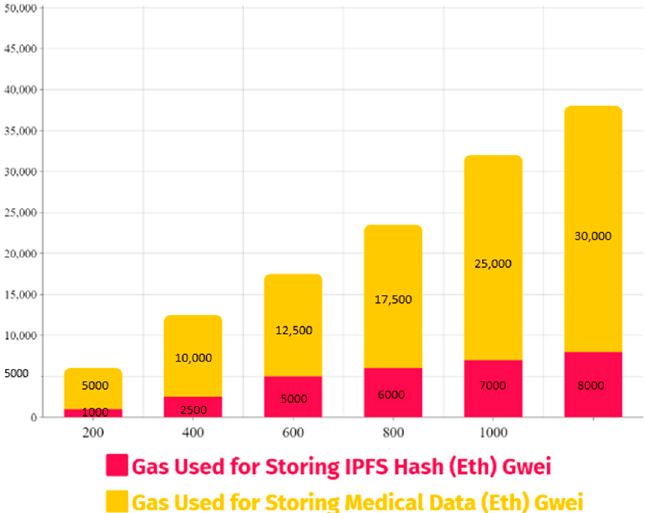
Figure 14. Medical data storage costs projected vs. IPFS on blockchain.